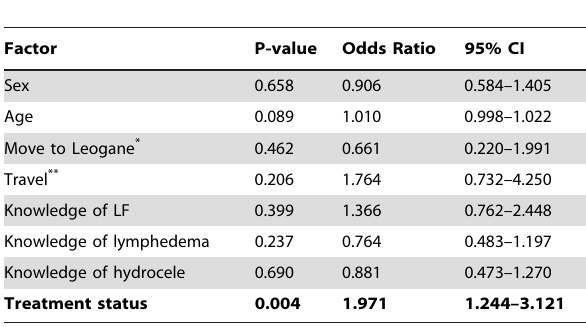
Table 5. Potential factors for infection status.